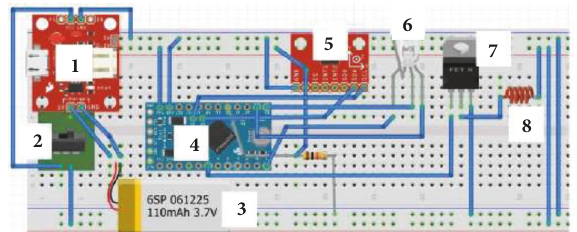
Figure 8: Parachute system electronic circuit diagram: 1 – charging unit;2 - switch;3 – Lithium polymer battery; 4 -microcontroller;5 – accelerometer- gyroscope; 6 – LED diode; 7 – MOS type transistor; 8 – nichrome